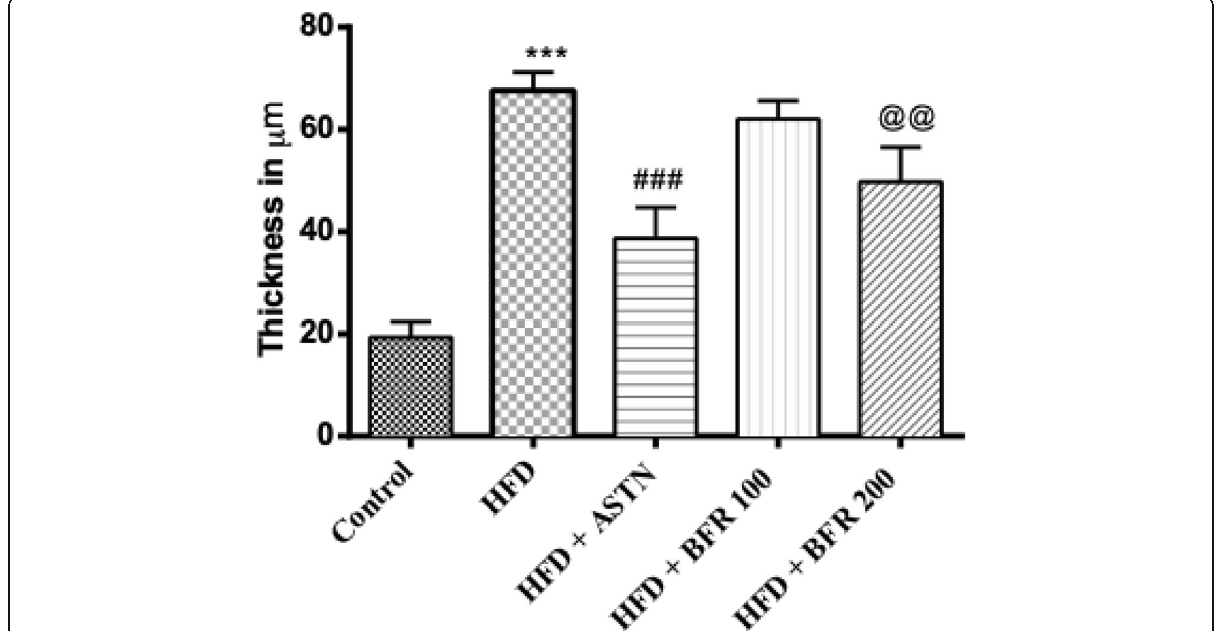
Fig. 7 Effect of BFR and ATSN in aortic wall thickness of high-fat diet-fed rats. Data were expressed as mean ± SD. Comparison made between HFD vs control and HFD + ATSN vs HFD group, HFD + BFR vs HFD. Statistical significance at @@ p < 0.01 and *** ,### p <